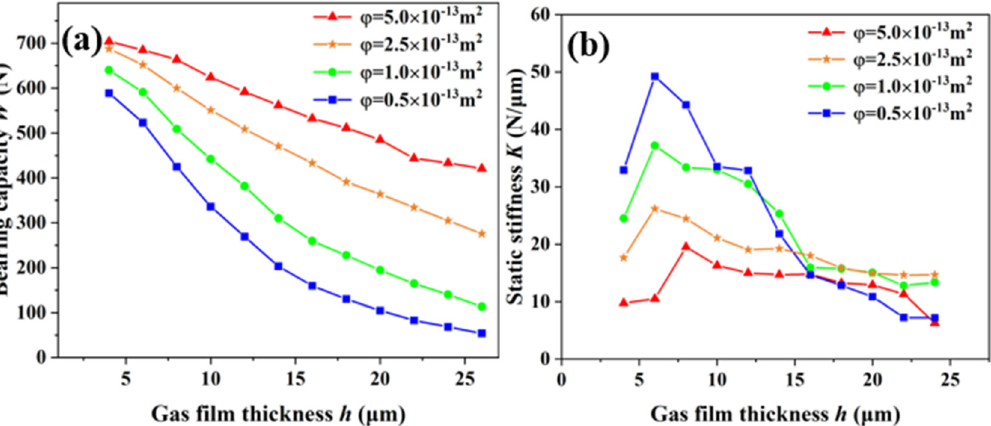
Figure 8. Static characteristics of aerostatic bearing under different permeabilities: ( a ) bearing capacity; ( b ) static stiffness.